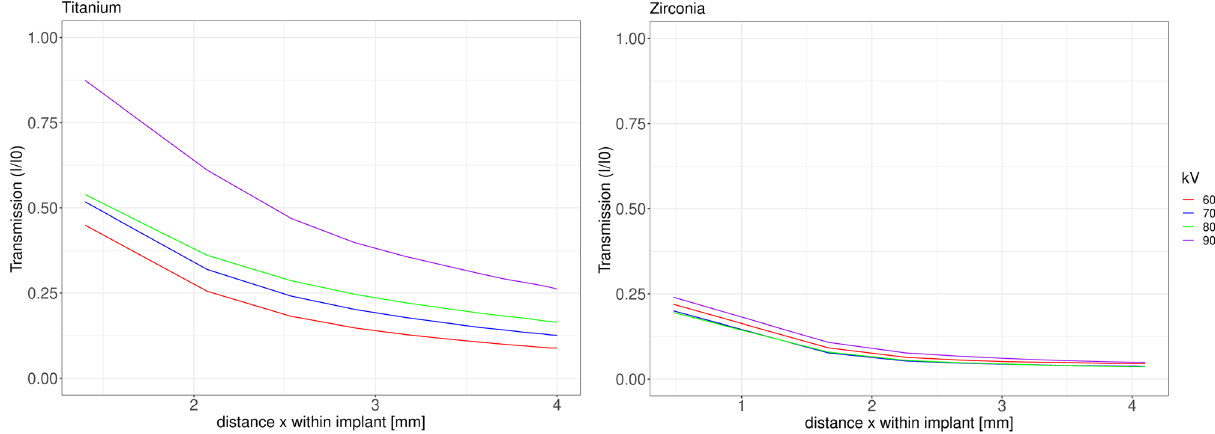
Figure 4. Transmission profiles for both materials and the four different beam energies averaged over both acquisitions. Note the transmission differences between the materials at equal distances within the material and the similarity of the transmission profiles for Y-TZP and all energies.